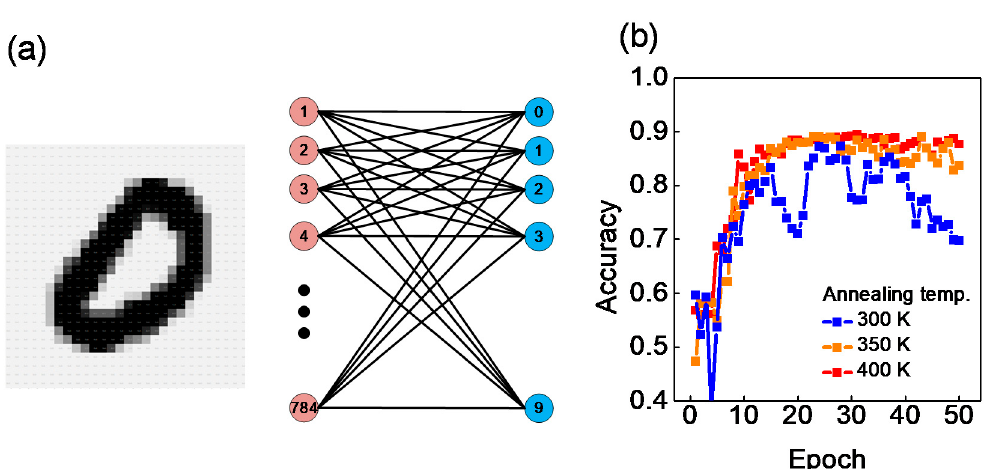
Figure 8. Deep neural network simulation using MNIST: ( a ) Single-layer network including input and output nodes; ( b ) Accuracy as a function of epoch for devices with different annealing temperatures (300, 350, 400 K).